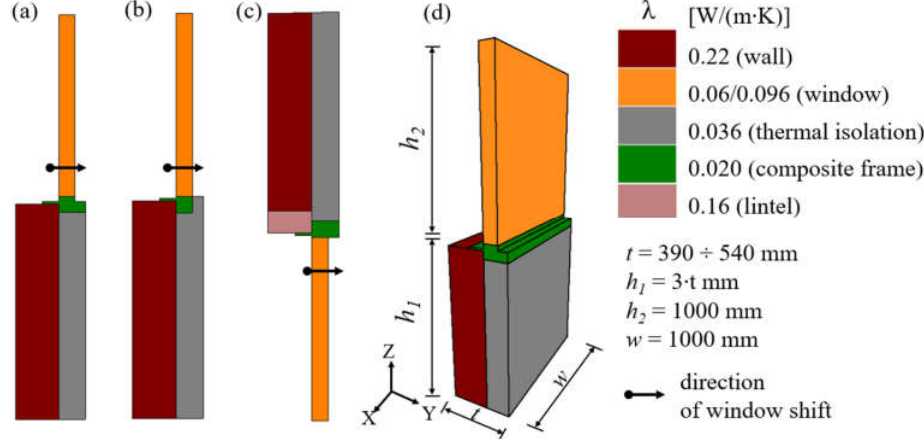
Figure 7. The model outline for cross-sections: ( a ) bottom, ( b ) side, ( c ) top, ( d ) wall dimensions. A 3D numerical analysis with steady-state heat flow was applied. The following boundary conditions were used: heat transfer resistances R si = 0.13 and R se = 0.04 (m 2 · K)/W for horizontal heat flow, R si = 0.10 (m 2 · K)/W for upward and R si = 0.17 (m 2 · K)/W for downward heat flow. The internal and external temperatures were assumed to be constant: T i = 20 ◦ C and T e = − 20 ◦ C. The wall and the mounting frame were modelled with hexahedral elements. In Figure 8, the materials and the surface boundary conditions are marked with different colours.